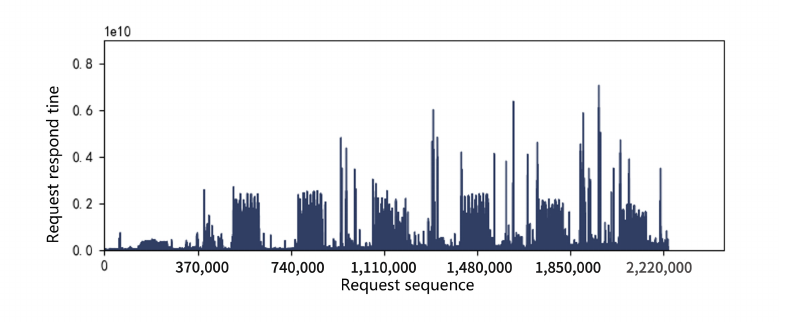
Figure 3. Request response time distribution in 2D SSDs.